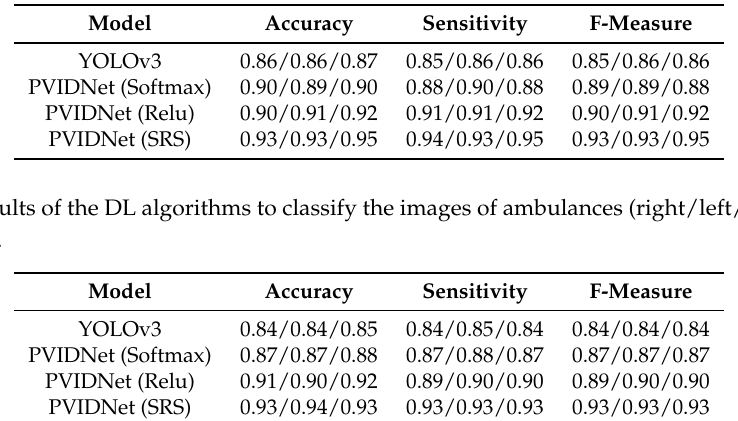
Table 12. Results of the DL algorithms to classify the images of buses (right/left/front) in the testing phase.